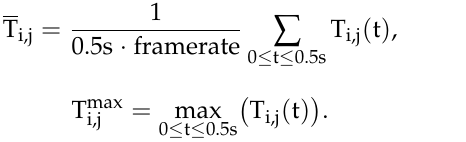
Table 4. Overview of the optimized cutting speed and cut edge quality for static beam shaping and longitudinal, linear beam oscillation. Improvements or degradations compared to static beam shaping have been indicated symbolically and in percentiles.